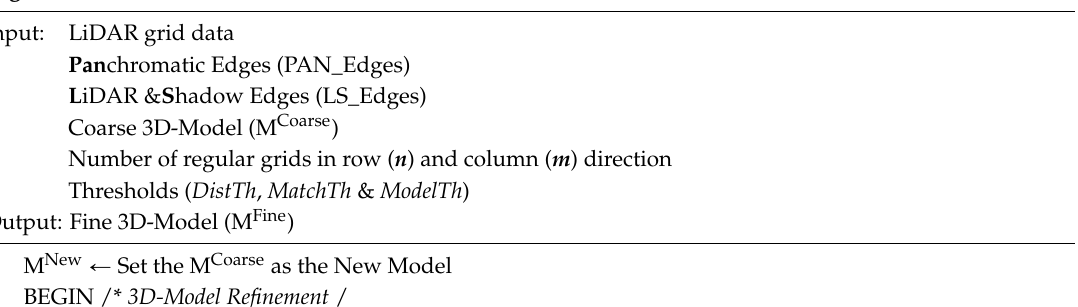
Algorithm 3 ICEPM and Fine 3D-Model